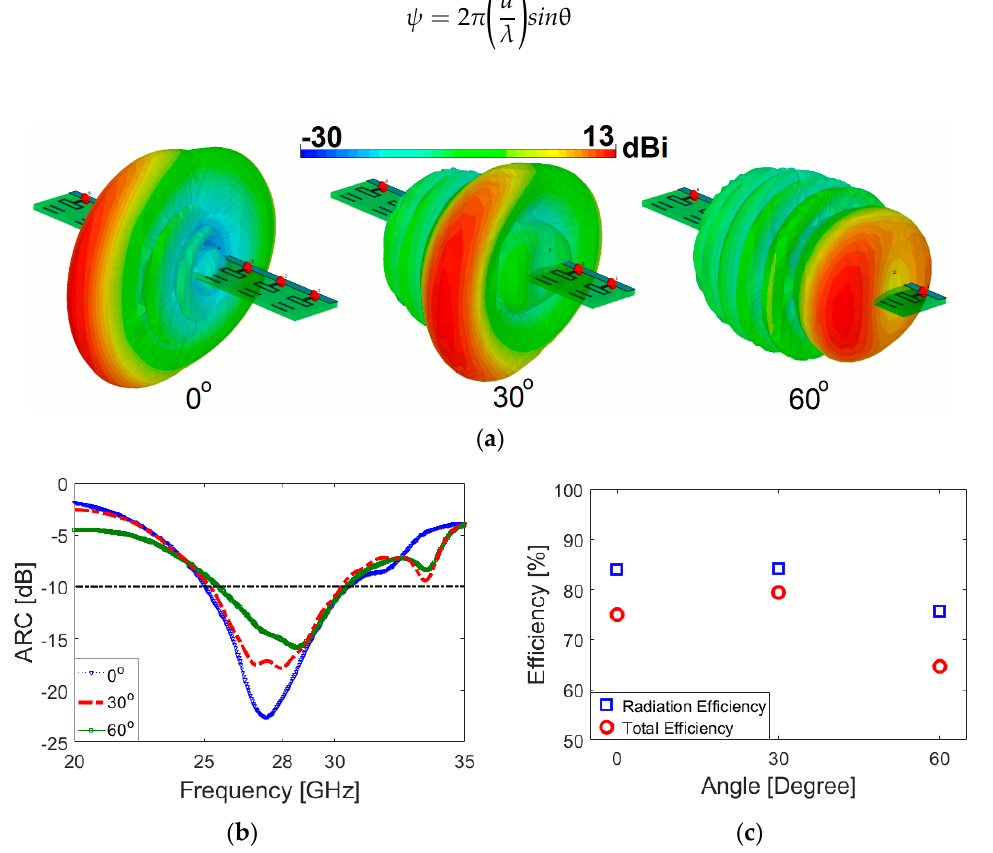
Figure 20. ( a ) Radiation beams, ( b ) active reflection coefficient, and ( c ) efficiencies at different Figure 20. ( a )Radiationbeams,( b )activereflectioncoefficient,and( c scanning angles.